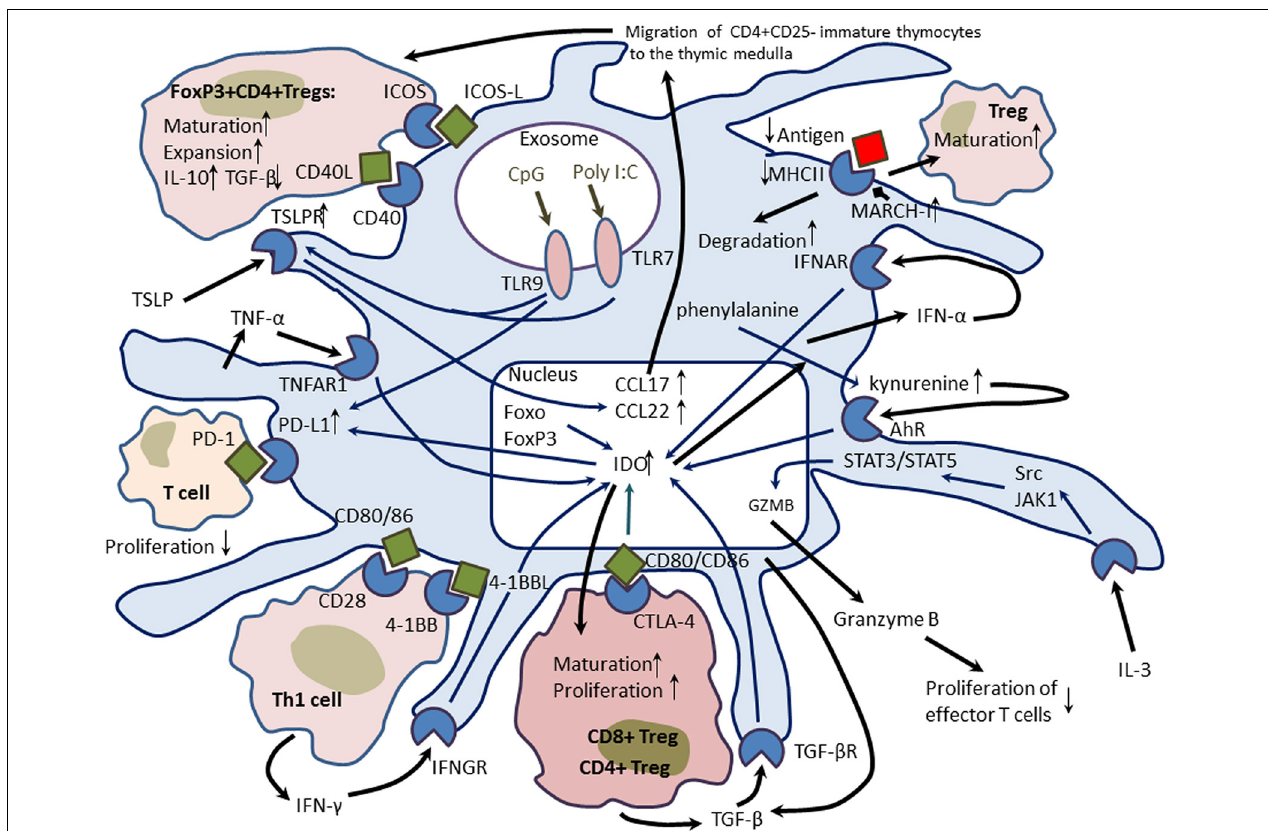
FIGURE 3 | Tolerogenic properties of plasmacytoid dendritic cells (pDCs). pDCs utilize several molecular mechanisms to induce tolerogenic properties. When phosphorylated, indoleamine-pyrrole 2,3-dioxygenase (IDO), an enzyme catabolizing L-tryptophan to N-formylkynurenine acquires potent immunomodulatory properties. IDO promotes differentiation of naïve T cells to inducible CD4 + and CD8 + regulatory T cells (Tregs) through cytotoxic T-lymphocyte antigen 4 (CTLA4)/CD80 pathway. In pDCs, IDO expression could be induced by multiple mechanisms including interferon (IFN)- γ -, IFN- α -, and transforming growth factor (TNF)- β -dependent pathways. Transcription factors Foxo and FoxP3 also stimulate IDO production. Kynurenine, a product of the IDO-catalyzed reaction can up-regulate IDO via a positive autocrine feedback mediated by the aryl-hydrocarbon receptor (AhR). IDO can up-regulate expression of the immunosuppressive molecule PD-L1 (programmed death-ligand 1) on the surface of pDCs. PD-L1 interaction with the PD-1 molecule decreases proliferation of the target T cell. Stimulation of